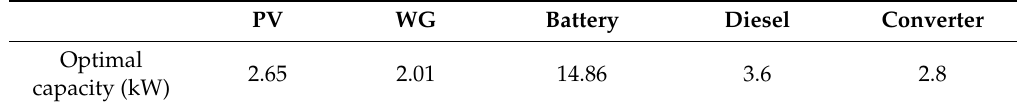
Table 6. Optimal size and cost of each